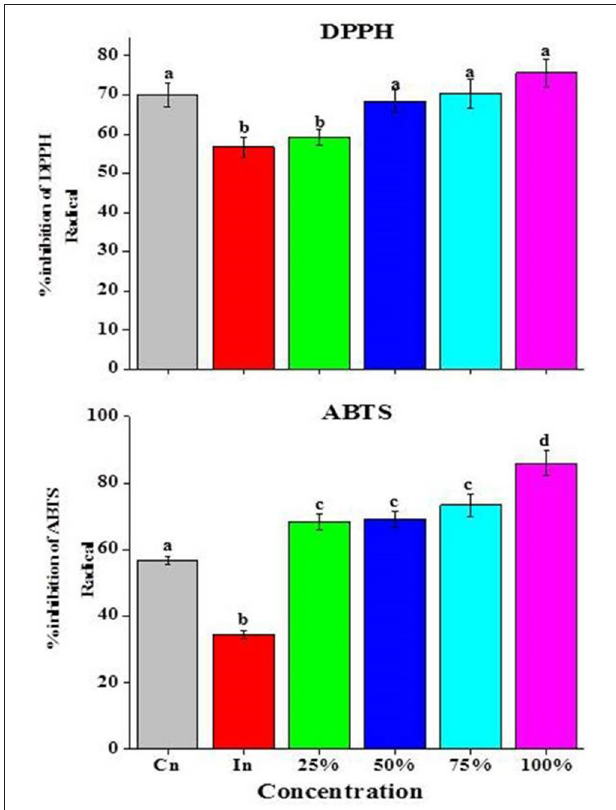
FIGURE 6 | Effects of Z. armatum DC EO on 2,2-diphenyl-1-picrylhydrazyl (DPPH) and ABTS free radical scavenging activity assays of tomato fruits inoculated with A. alternata . CN, control; IN, inoculated; 25, 50, 75, and 100% indicate concentrations of EO used. Values represent mean ± standard error, where number of biological repeats is five ( n = 5). Different letters (a–d) indicate significant differences from each other in all combinations at p <